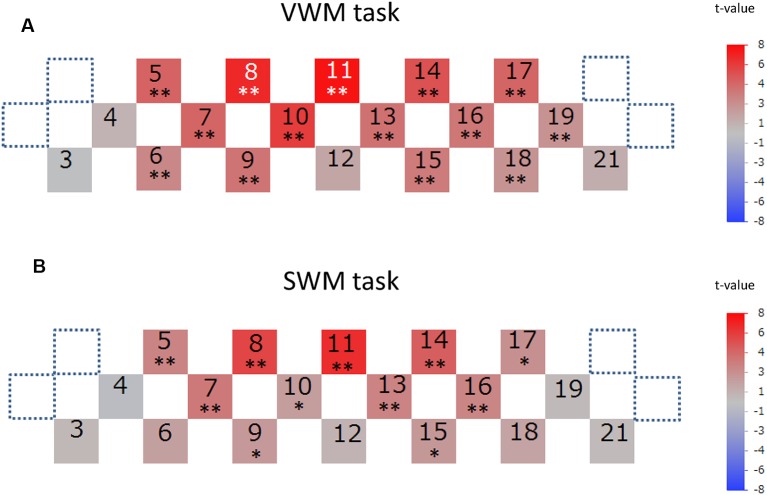
The significance of task-related prefrontal cortex (PFC) activation. Channels with significant task-related oxy-hemoglobin signal changes during the activation period at each channel across participants are illustrated by colored squares in the VWM task (A) and SWM task (B). The color spectrum bars at the right end indicate the t-value scale. Channels with statistical significance are indicated by asterisks (*q < 0.05, **q < 0.01).